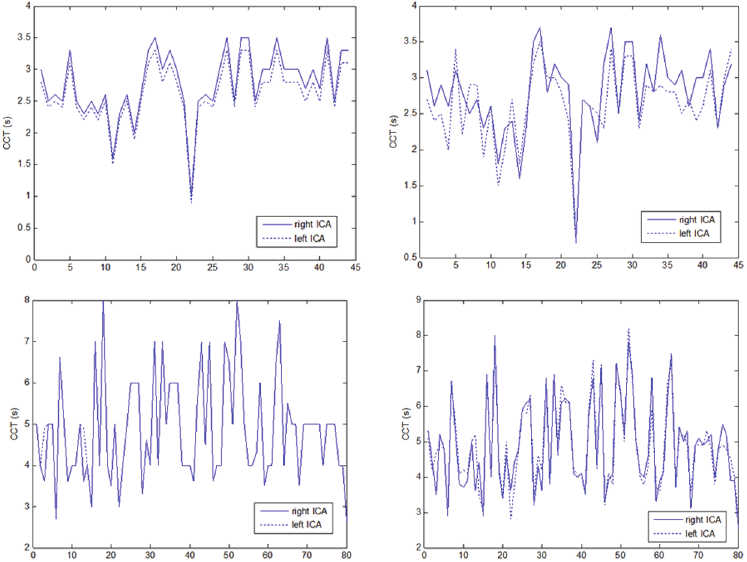
Fig 2. The plots in the panels indicate the close similarity between the CCT evaluations by rater and side. Upper panels: the CCT measurements at the right and left side ICA across the subjects in the control group evaluated by first rater (left panel) and second rater (right panel).